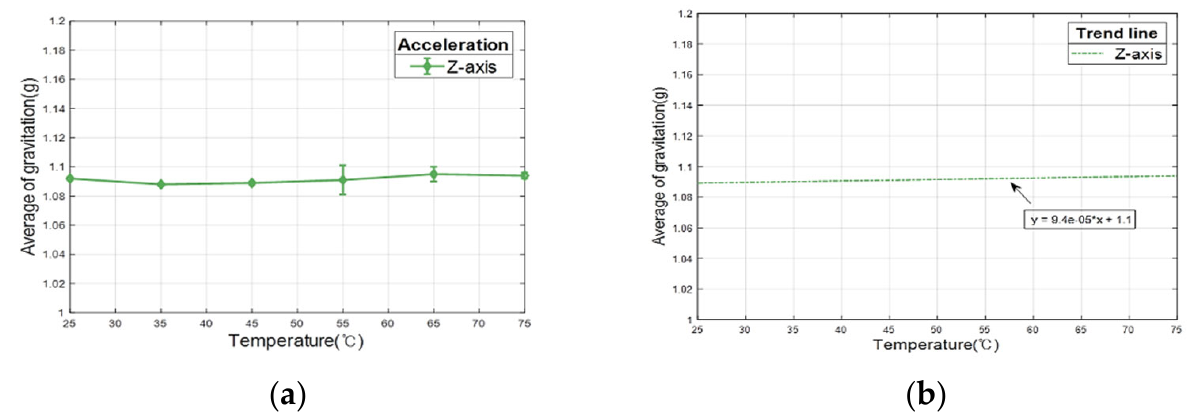
Figure 6. Trendline of measurement values by temperature in the Z ‐ axis of the accelerometer. ( a ) Averages and standard deviations of the measured values with temperature of the Z ‐ axis of the accelerometer. ( b ) Trendline of the measured values with temperature in the Z ‐ axis of the accel ‐ erometer.